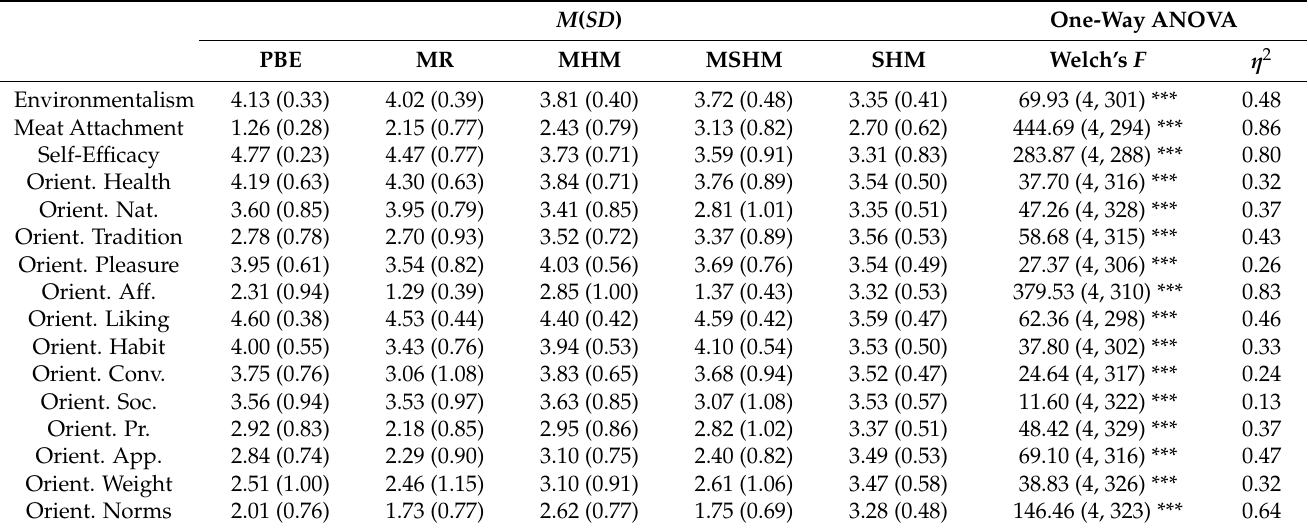
Table A1. Means and mean differences of profiling variables.